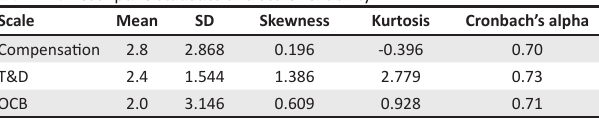
TABLE 2: Descriptive statistics and scale